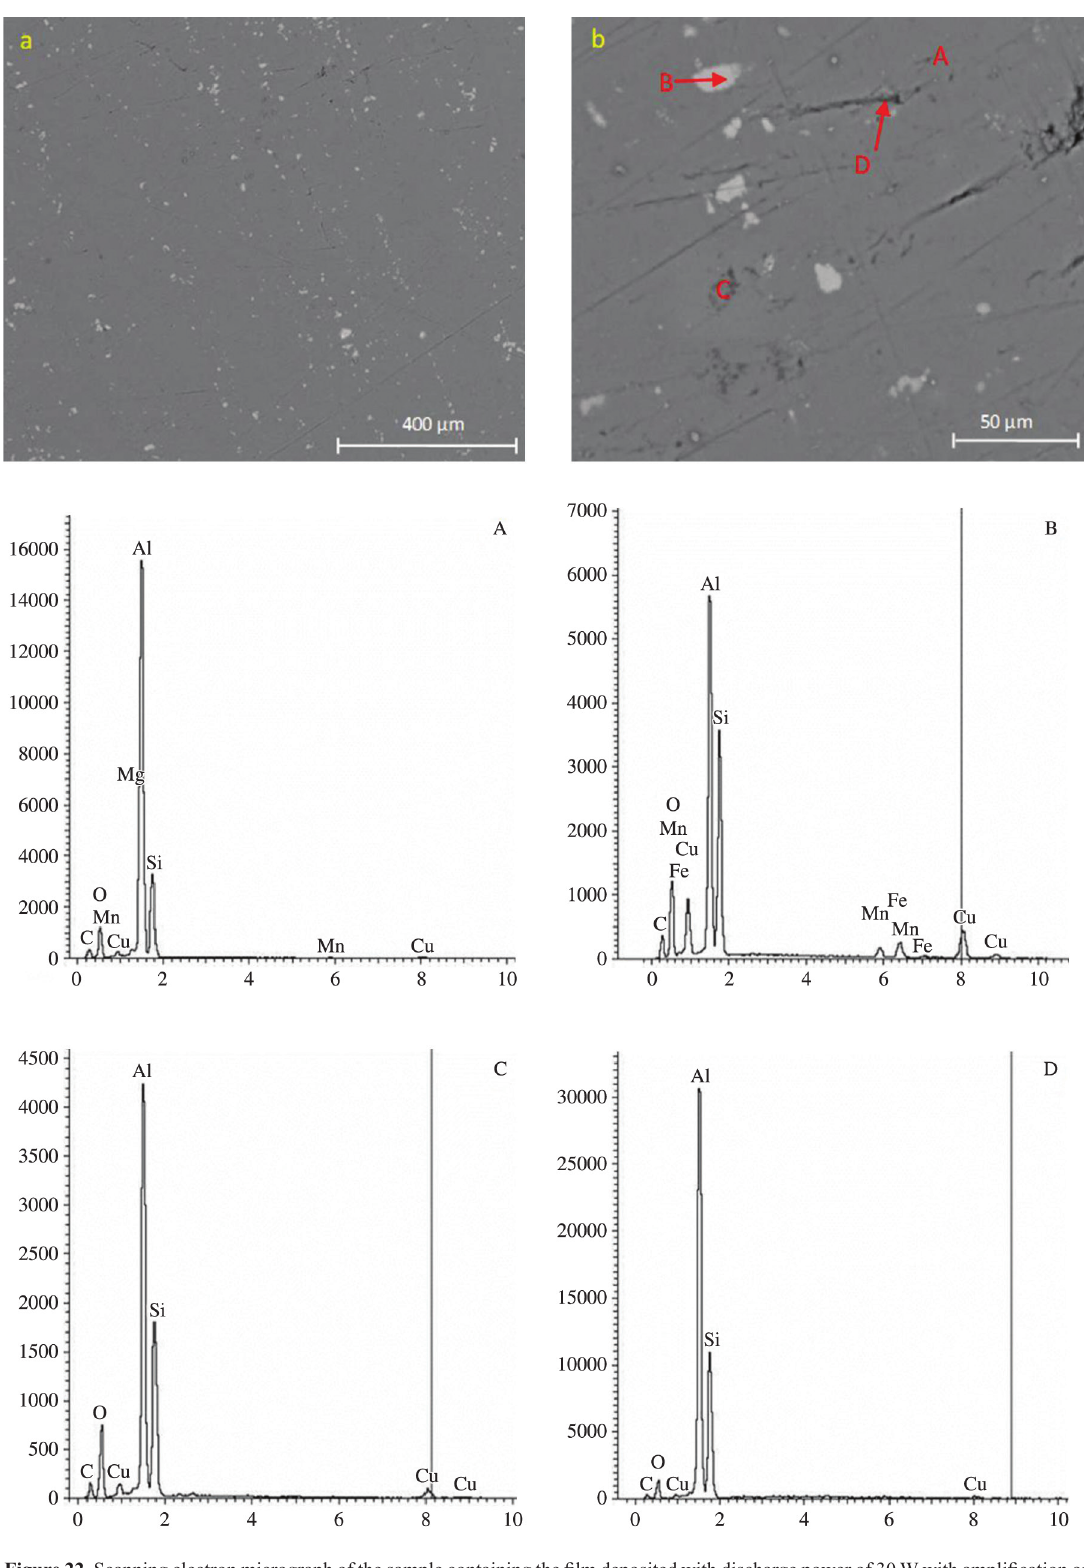
Figure 22. Scanning electron micrograph of the sample containing the film deposited with discharge power of 30 W with amplification of (a) 250 times and (b) 1500 times. A, B, C and D are energy dispersive spectra of the regions A, B, C and D of the micrograph shown in